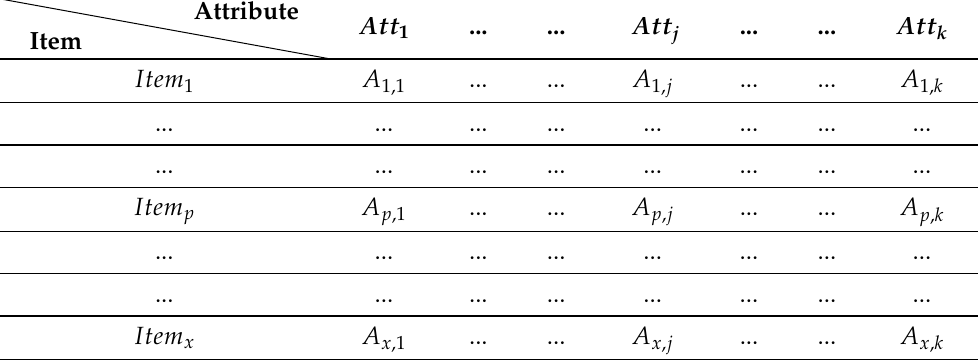
Table 6. A binary matrix with k categorical attributes and x items.